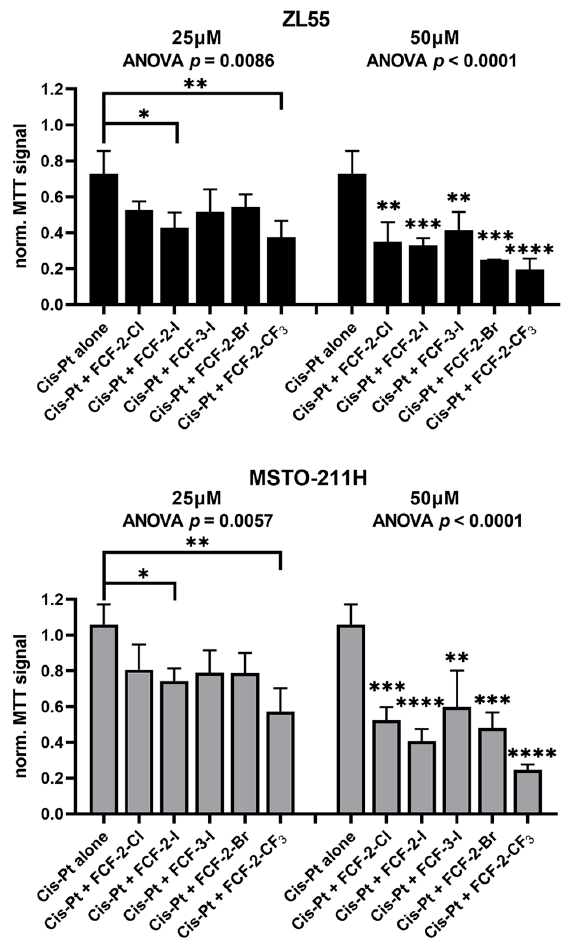
Figure 4. MTT assay reporting the decrease in proliferation/viability of either (I) naïve MM cells exposed to cisplatin alone, or (II) partially cisplatin-resistant MM cells additionally treated with FCF and its analogs for a total of 168 h. ZL55 ( upper ) and MSTO-211H ( lower ) MM cells were exposed